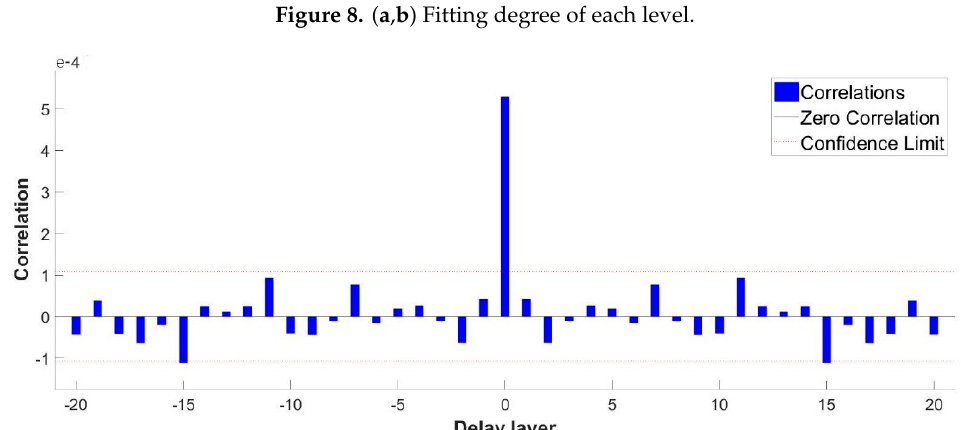
Figure 8. ( a , b ) Fitting degree of each level.